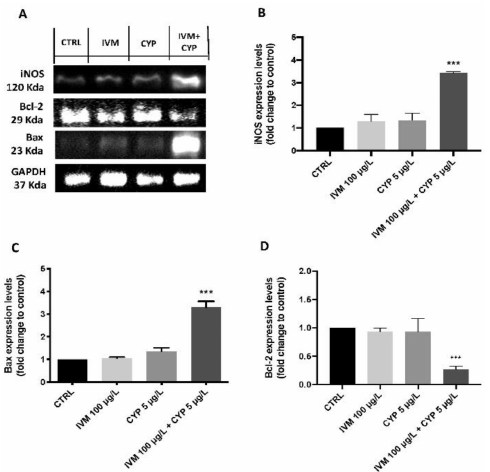
Figure 7. Effects of IVM and CYP on protein levels of iNOS and apoptotic pathway (bax and bcl-2) on larval zebrafish. Western blot analysis ( A ). Each figure corresponds to a representative replicate from three experiments for iNOS, Bax, and bcl-2 ( A – D ). Values = means ± SD of three independent experimental datapoints: *** at p < 0.001 against